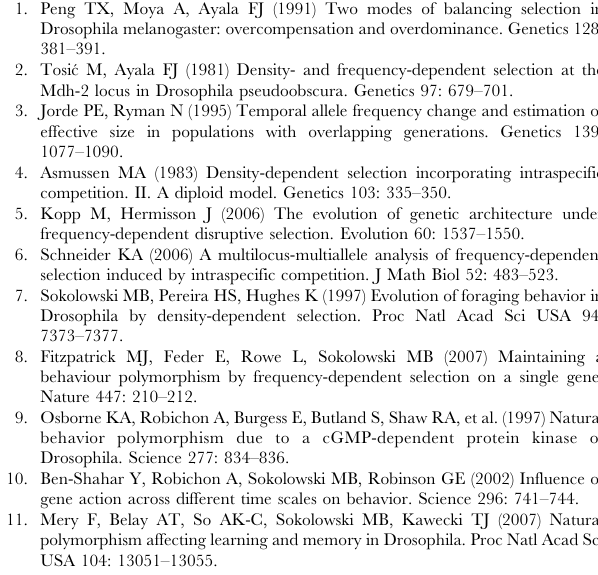
Table S2 Statistical analysis of the behavioral studies. Paired t -test statistical analysis of the data presented in figures 2, 3 and